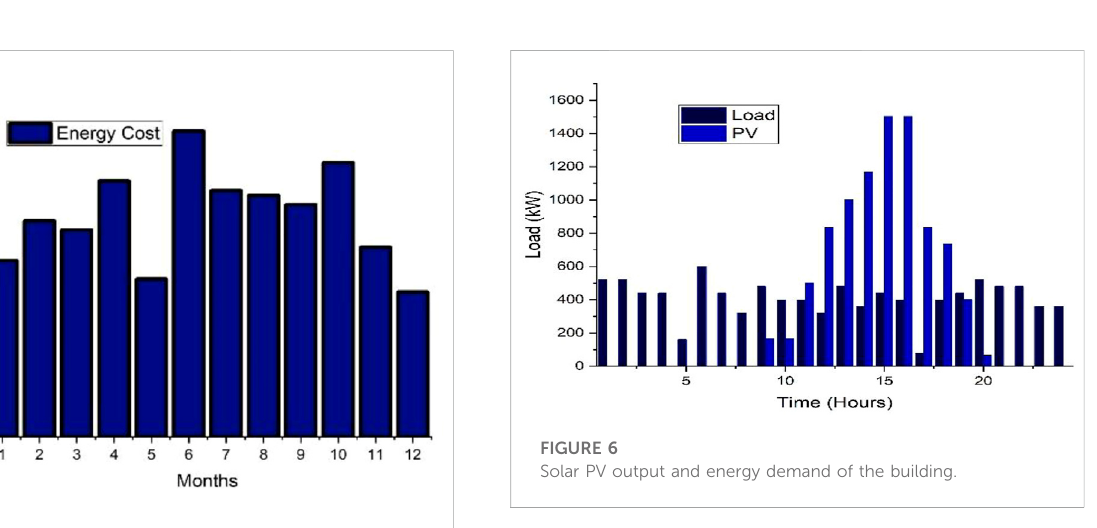
FIGURE 5 Monthly consumption cost of the campus.